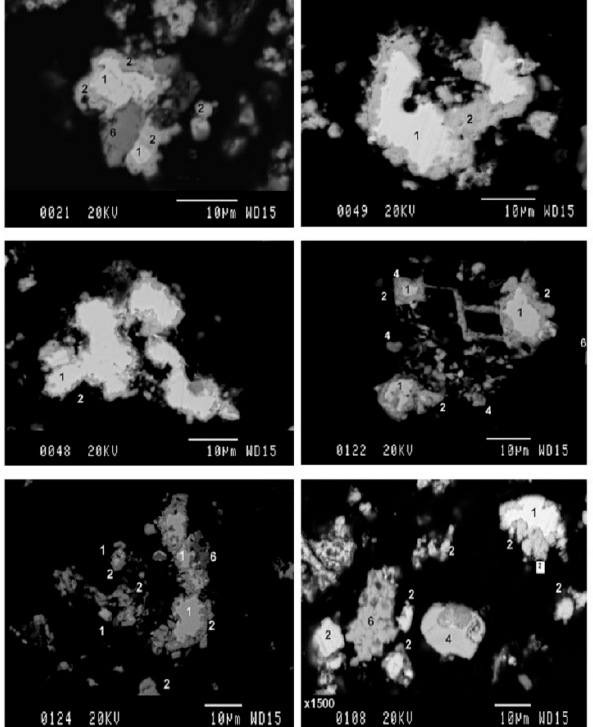
Figure 13. Silver selenide Ag 2 Se (phase 1), AgCl (phase 2), O-Sb-Pb (phase 4), BaSO 4 (phase 6).